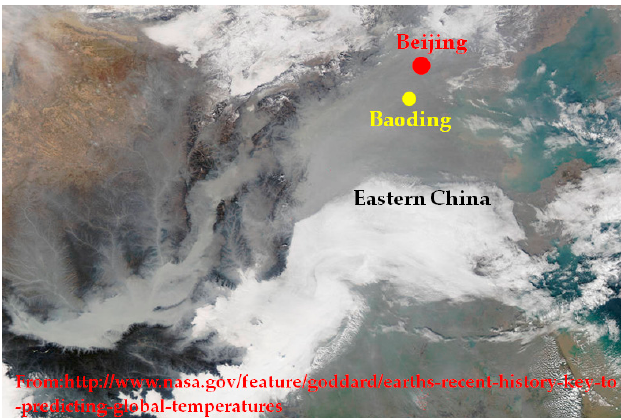
Figure 1. The spatial distribution of fog and haze (F-H) of eastern China on 7 December 2015.